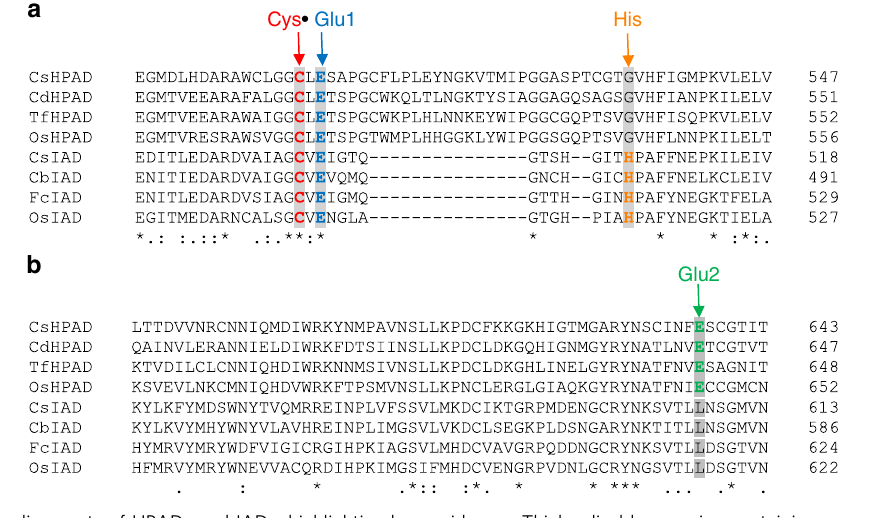
Fig. 5 Multiple-sequence alignments of HPADs and IADs, highlighting key residues. a Thiyl radical loop region containing conserved Cys (cid:129) and Glu1 residues, highlighted in red and blue, respectively. A His residue possibly involved in the catalytic mechanism of IAD is coloured orange (Cd Clostridium dif fi cile ; Tf Tannerella forsythia ; Cb Clostridium botulinum ; Fc Faecalicatena contorta ). b Region containing Glu2, highlighted in green. Glu2 is conserved in HPADs but not in